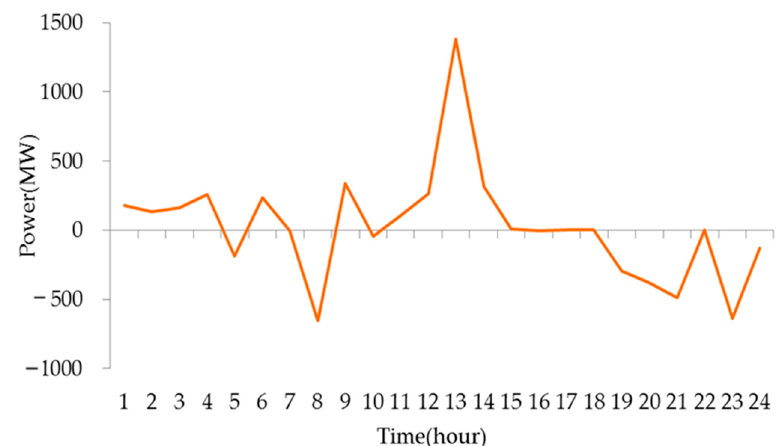
Figure 9. Pumped storage power outputs in Case 2.